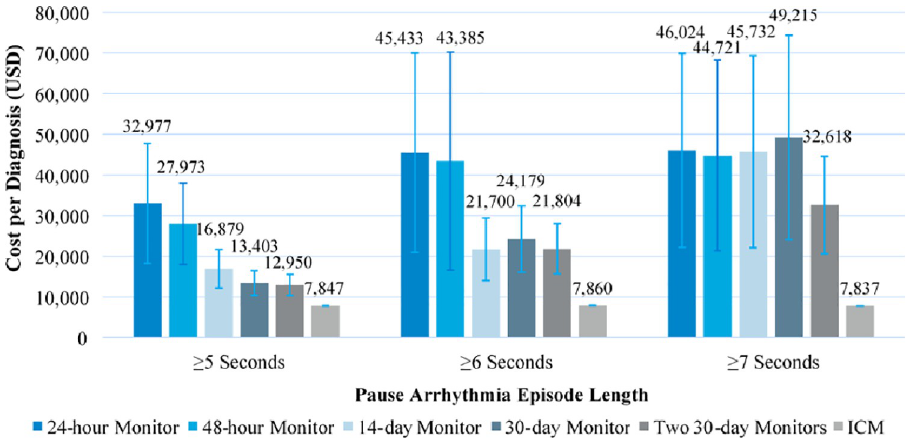
Fig 3. Cost per diagnosed patient with conventional monitoring strategies vs. ICM. Data represent mean ± standard deviation from 1,000 simulations. Abbreviations: ICM, insertable cardiac monito; USD, United States